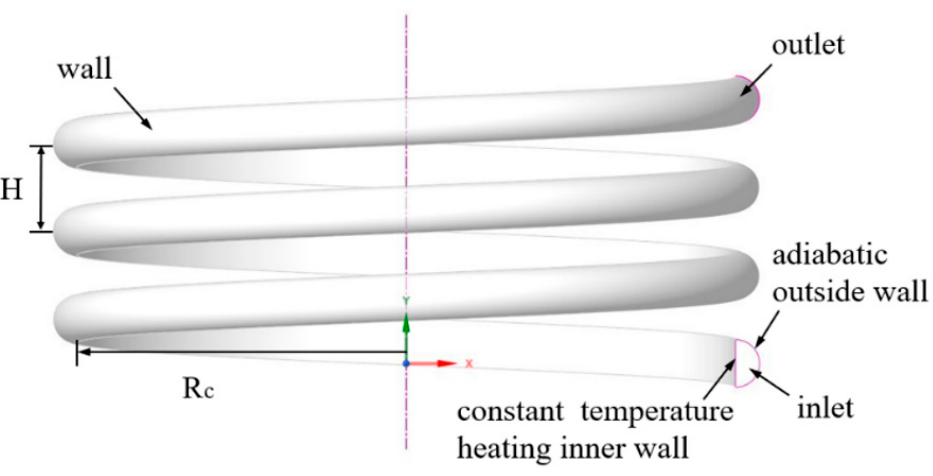
Figure 3. Illustration of a helical pipe jacket model.